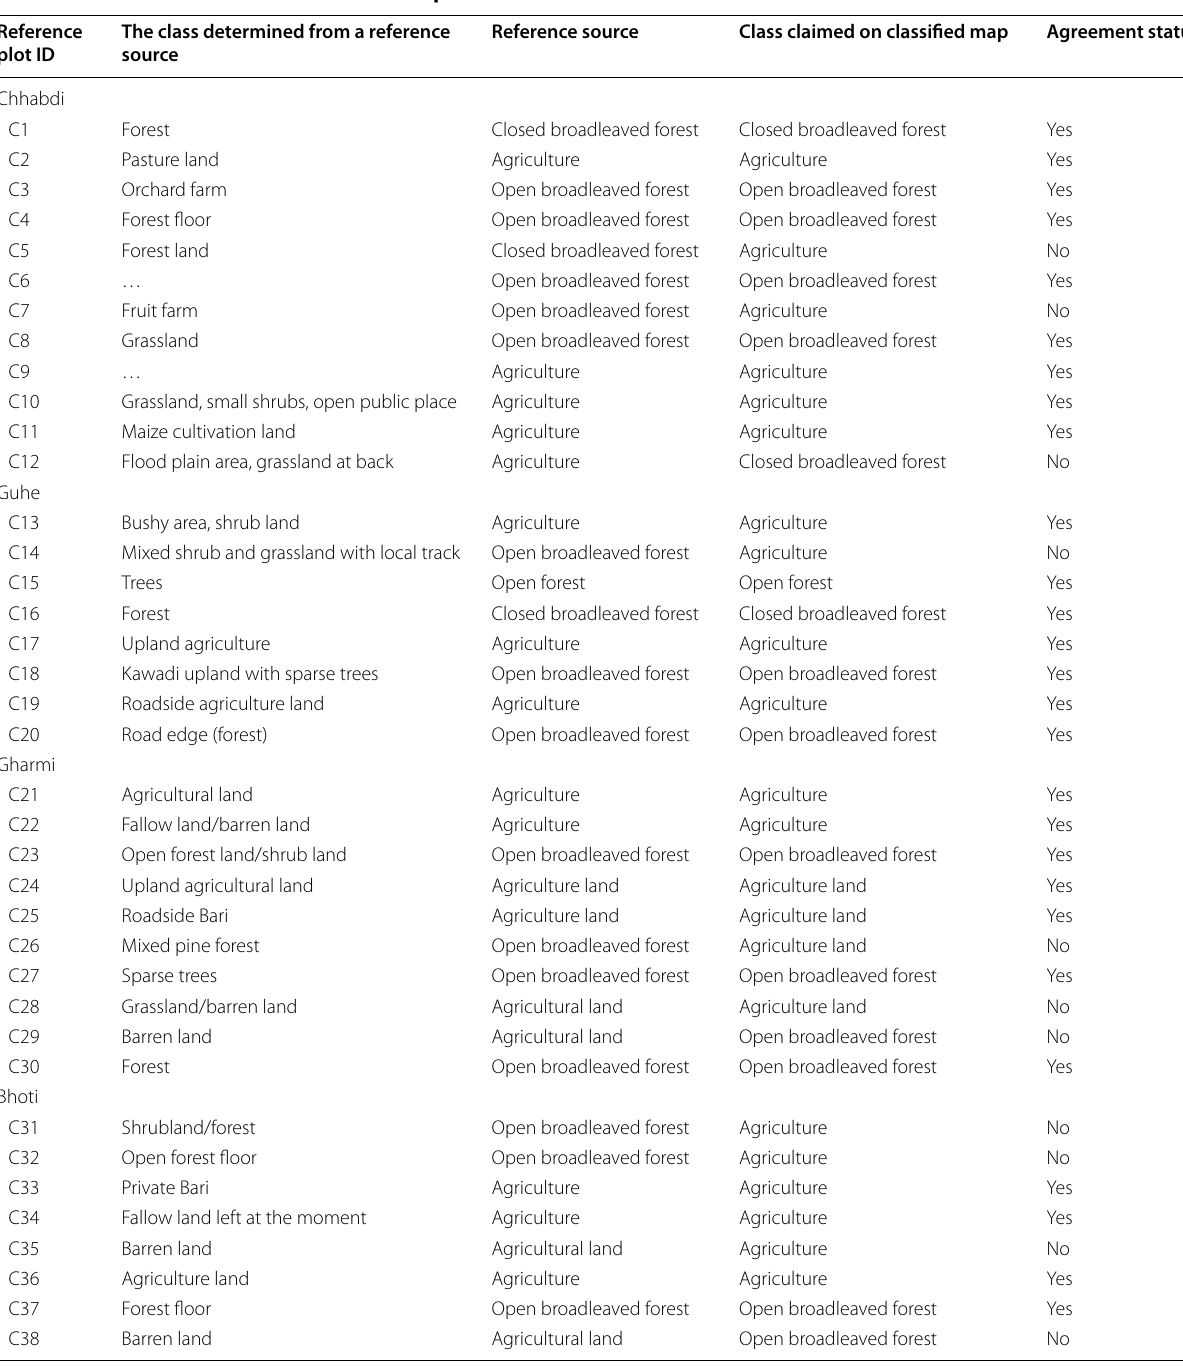
Table 4 Results obtained from classified map and reference source in various watersheds Reference The class determined from a reference plot ID